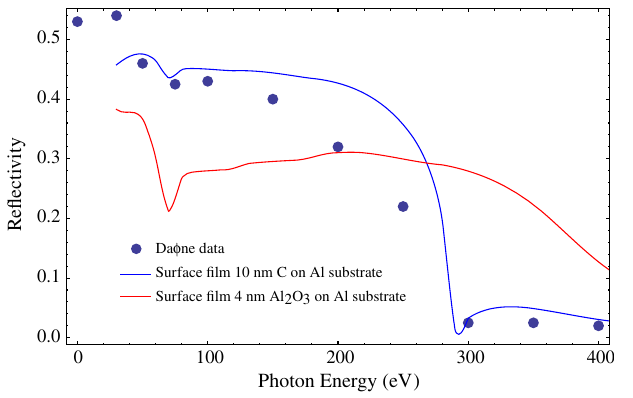
FIG. 11. Comparison of data [18] and model for diffuse scattering at 85° from a rough ( σ ¼ 200 nm) surface layer on an aluminum